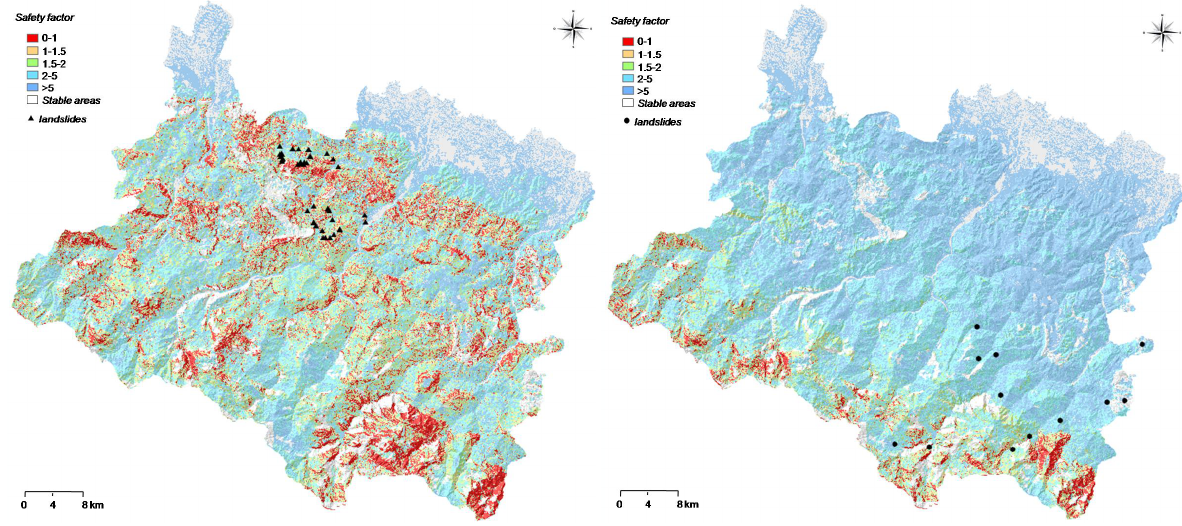
Fig. 16. Influence of land use on the SLIP analysis for the study area: (a) F s map on the 11 April 2005; (b) F s map on the 3 December 2005.